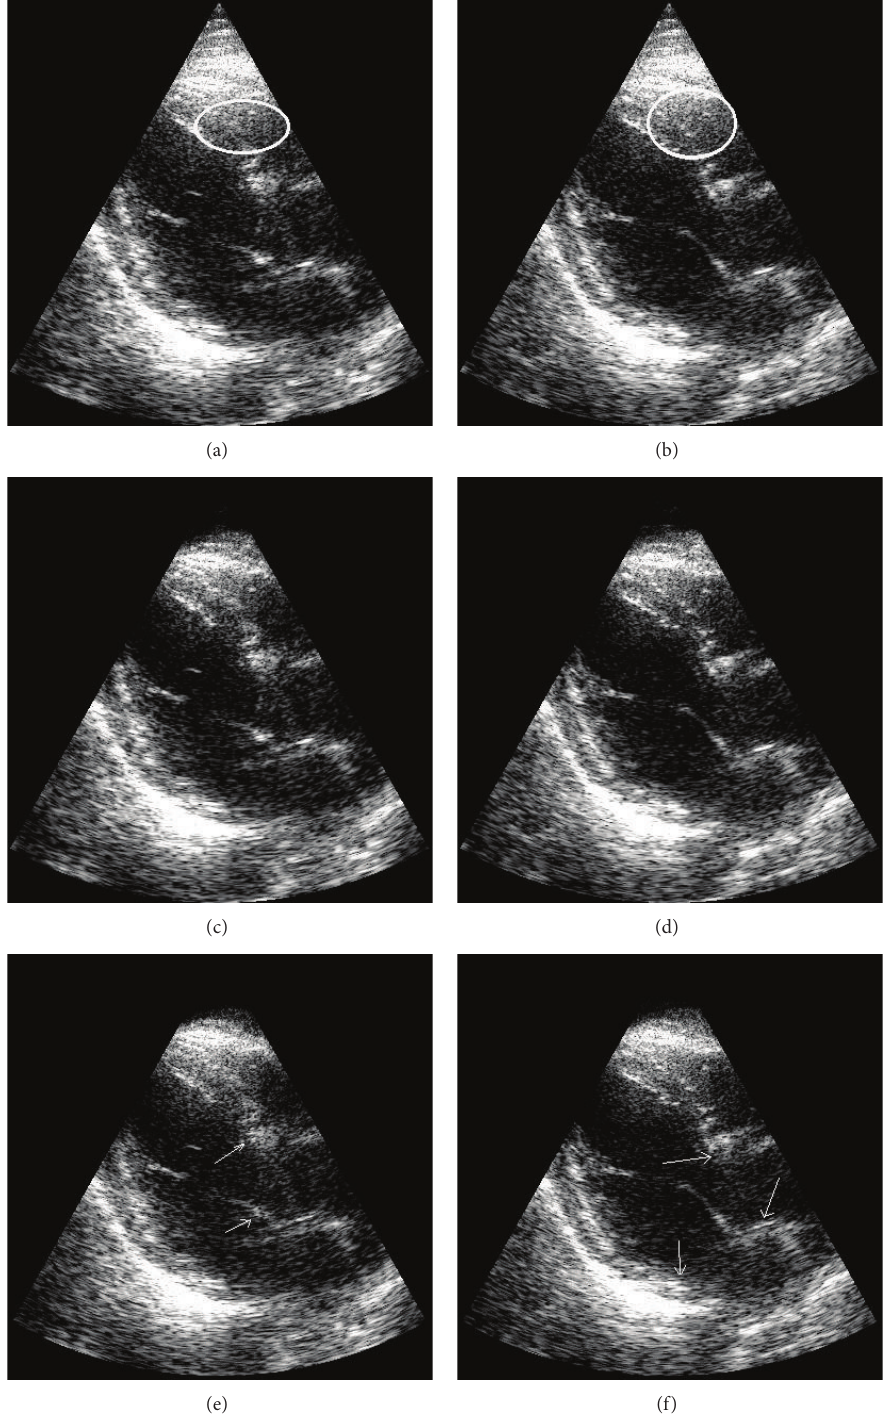
Figure 12: Two examples of an apical view of heart images are illustrated before filtering (a, b) and after clutter removal with MCA (c, d) and after applying SVF (e, f). Ellipses in the unfiltered images indicate regions of clutter artifacts due to multipath reverberations. The arrows point to regions of tissue incorrectly filtered. Images are shown on a log compressed linear gray scale mapping to 0 to 30